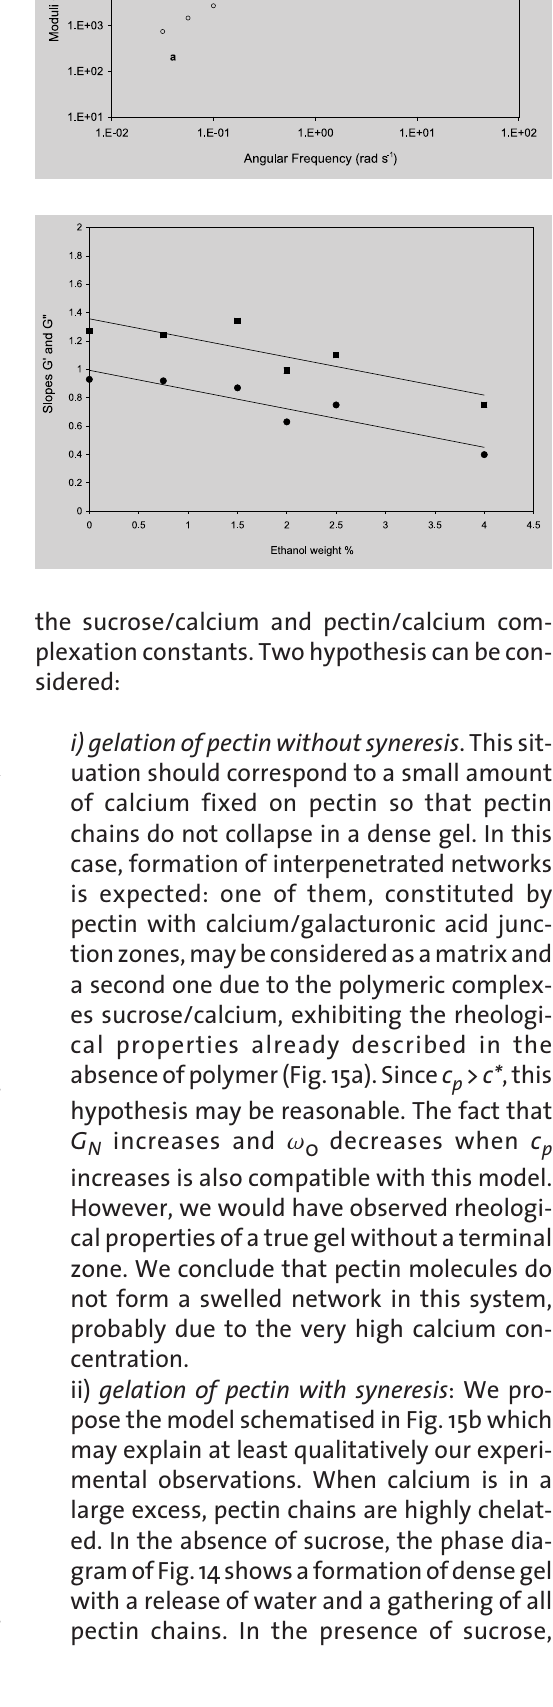
Figure 10 (left above): Typical variations of the storage and loss moduli ver- sus time: 1.) reference sys- tem: G ’ ( É ), G” ( D ); 2.) refer- ence system + 1 % ethanol: G ’ ( ü ), G” ( Ú ); 3.) reference system + 6 % ethanol: G ’ ( _ ), G” ( + ). Figure 11 (right above): Spectromechanical results (G’ ( Á , Ê ), G” ( É , ü )) for a.) the reference system and b.) the reference system